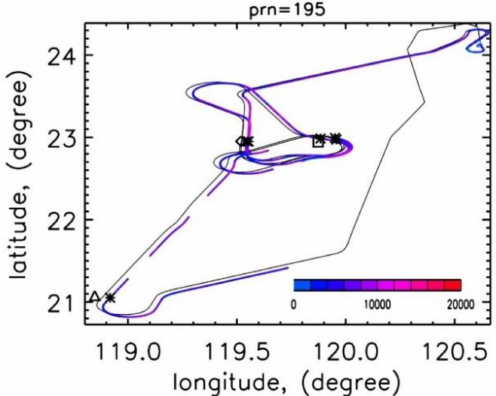
Figure 14. The actual flight path of AIDC reflectometry experiment conducted on 27 July 2020.